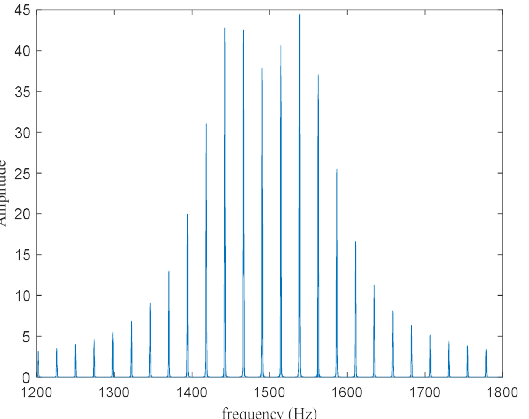
Figure 1. Spectrum of a PTFM waveform with a central frequency of 1500 Hz and a bandwidth of 200 Hz.